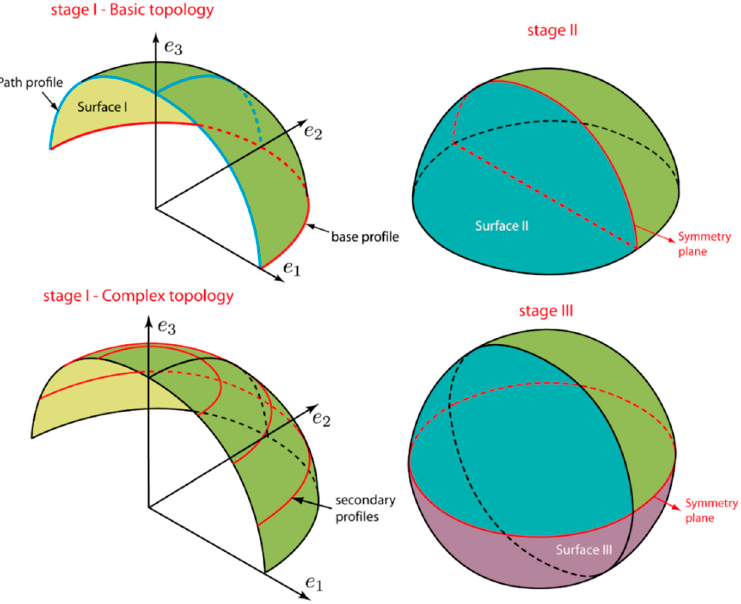
Figure 2. Stages for the geometric construction of the Valencia orange.